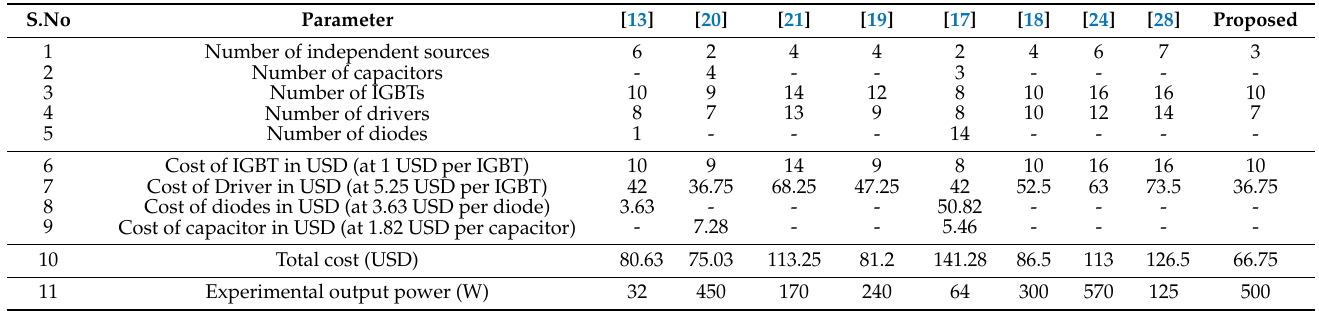
Table 2. Components and Cost